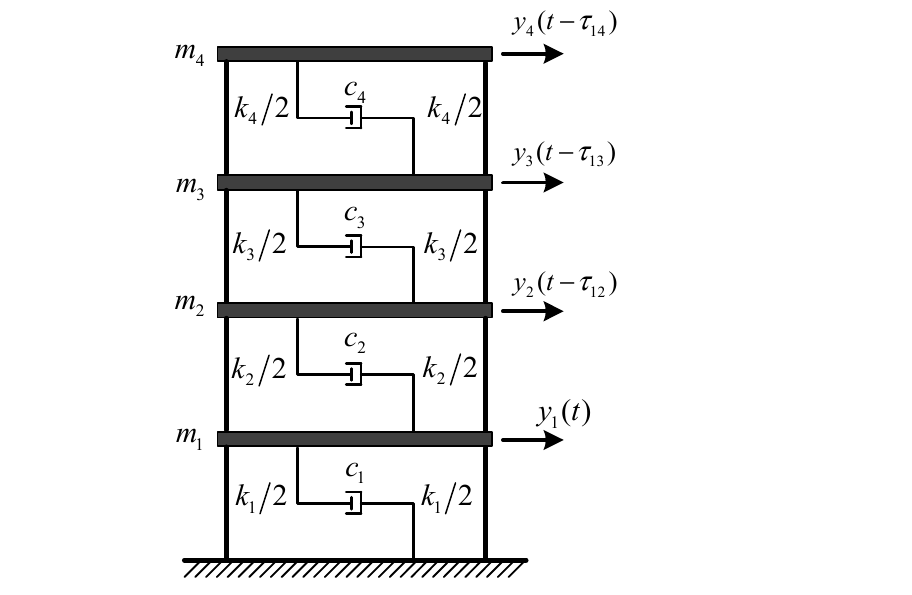
Figure 3. A linear time-invariant model of a four-story building. Each floor is excited by a stationary, zero-mean, Gaussian white noise. By adding state noise N ( 0, 0.01 ) and output noise N ( 0, 0.001 ) into the structure, then the structural responses under white noise excitation are simulated (SNR = 20 dB). All the responses have a duration of 100 s and the sampling rate is 50 Hz. Suppose that each floor has an independent acquisition unit for response collection. Four sets of dynamic responses with different lags are set intentionally to assess the impact of the non-synchronization on modal identification. The first channel is set as the referenced channel, and the relative time delays of other channels are shown in Table 1, where the positive sign indicates that the time is behind the reference timeline and vice versa. Table 1. Channel delays. Channel